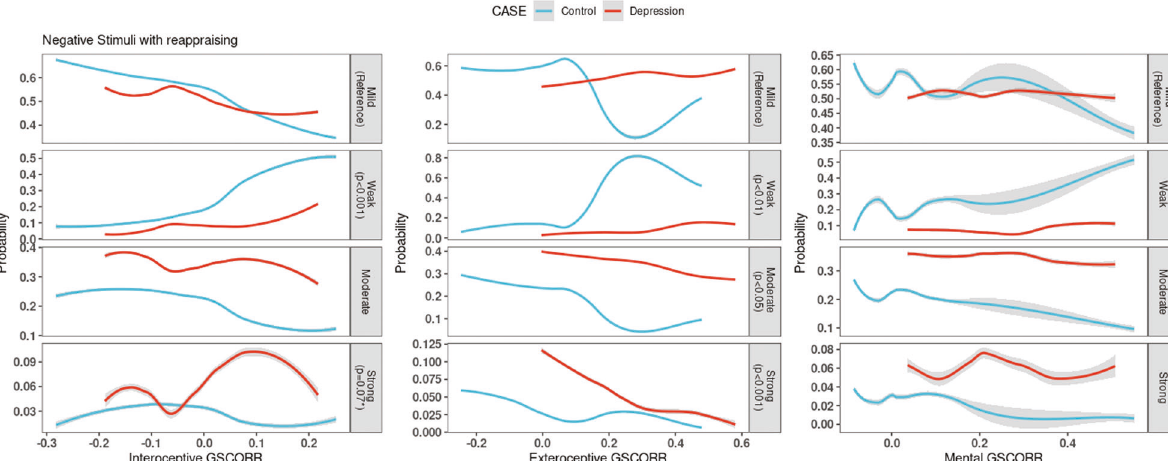
Fig. 5 Probability of emotional response according to GSCORR while reappraising the negative stimuli. The x -axis shows the GSCORR value while the y -axis shows the probability of emotional response relative to the reference. Signi fi cant or marginal results are highlighted in gray tabs with their respective p values. Blue color represents healthy controls while red represents MDD group. Increase in interoceptive self GSCORR increases the chance of weak emotional response by increasing in strong emotional response marginally ( p = 0.07, fi rst column). Increase in exteroceptive self GSCORR increases the chance of strong emotional response gradually, from weak to strong (second column). Mental self GSCORR has no signi fi cant response (third column). Overall, having a past MDD episode increases the probability of moderate and strong emotional reaction while it decreases the probability of weak emotional